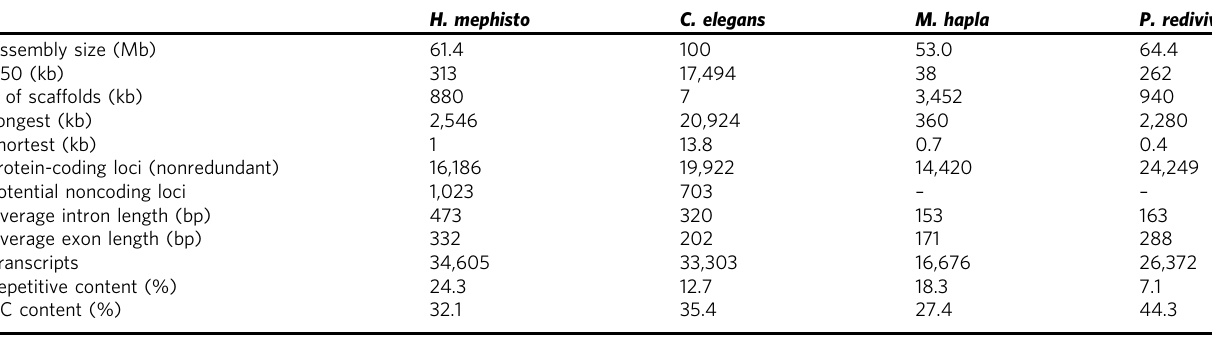
Table 1 Genome and transcriptome data for H. mephisto and comparison to C. elegans , M. hapla , and P.